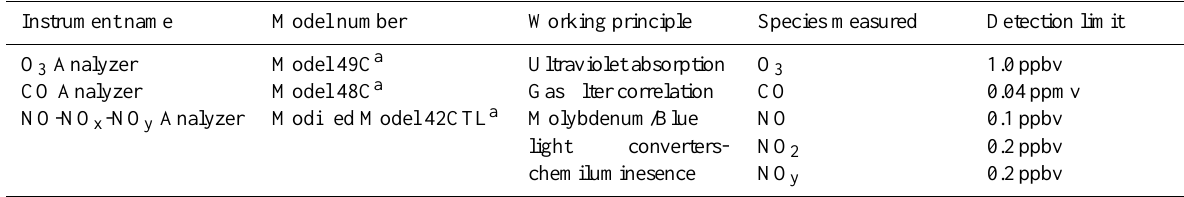
Table 1. Instruments for O 3 , CO, and NO-NO 2 -NO y